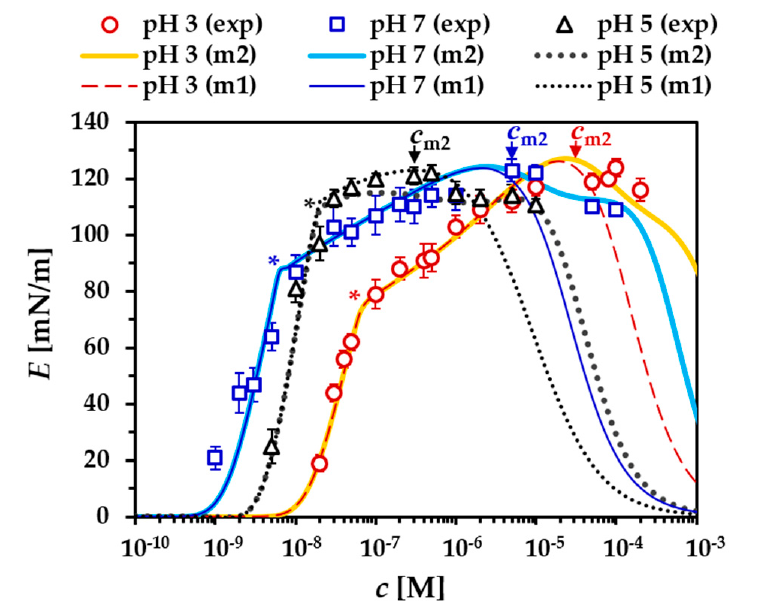
Figure 5. BLG adsorption layers at the water/air interface at different bulk pH. Dependencies of the measured dilational complex viscoelasticity modulus E and the computed high-frequency limiting elasticity E 0 on ( a ) surface pressure, E 0 ( Π ), E ( Π ) f,g , and ( b ) surface excess, E 0 ( Γ ), E ( Γ ) f,g ; f = 0.1 Hz, g ≈ 2.7%. Symbols are experimental data for E (exp), lines are best fits for the two-layer (m2) model, asterisks indicate Π * and Γ *, arrows indicate the onset of secondary layer formation at Π m2 and Γ m2 . Experimental and computed dependencies of the modulus E ( c ) f,g are presented in Figure 6. The precritical regions of the data sets at different pH are localized along the c -axis in the same way as in the isotherms of the surface pressure Π ( c ) and the surface excess Γ ( c ) (Figure 1) that follows from the theory.